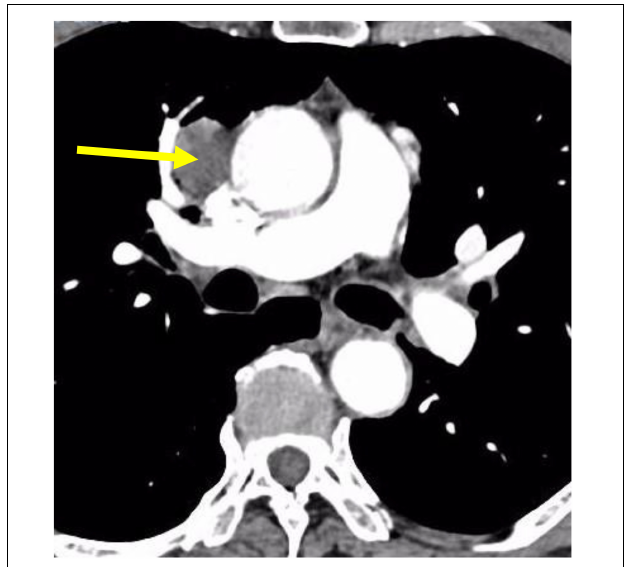
FIGURE 1 | CT scans of the patient showing thymic neuroendocrine carcinoma with a closed relationship of proximal